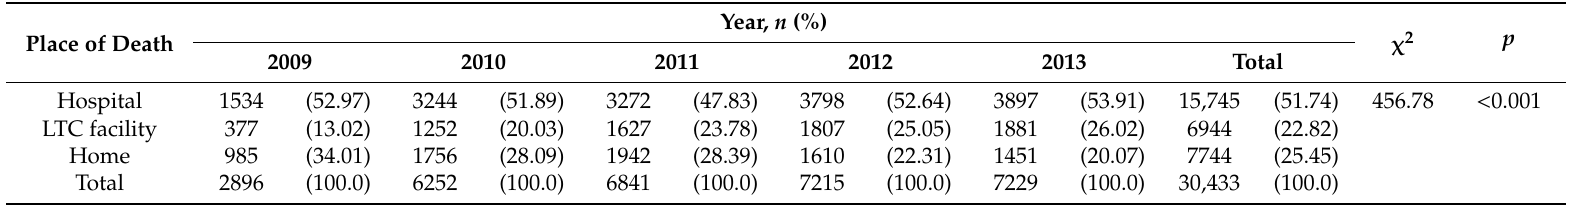
Table 4. Place of death of LTC beneficiaries by year ( N =